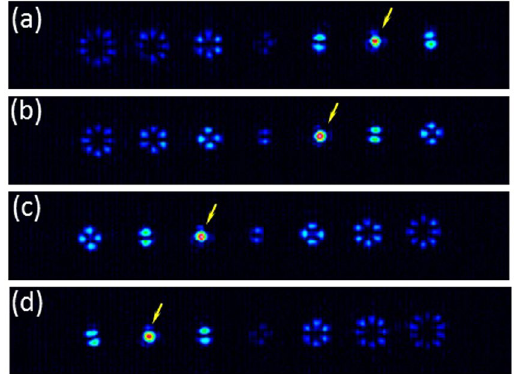
Figure 5. Experimental detection of input vector beam. A vertical linear analyzer is used in all cases. The input beam is generated with vertical linearly polarized light passing through a q -plate device with: ( a ) q = + 1, ( b ) q = + 1/2, ( c ) q = − 1/2, ( d ) q = − 1. The yellow arrow points the bright spot indicating the detection of a vector